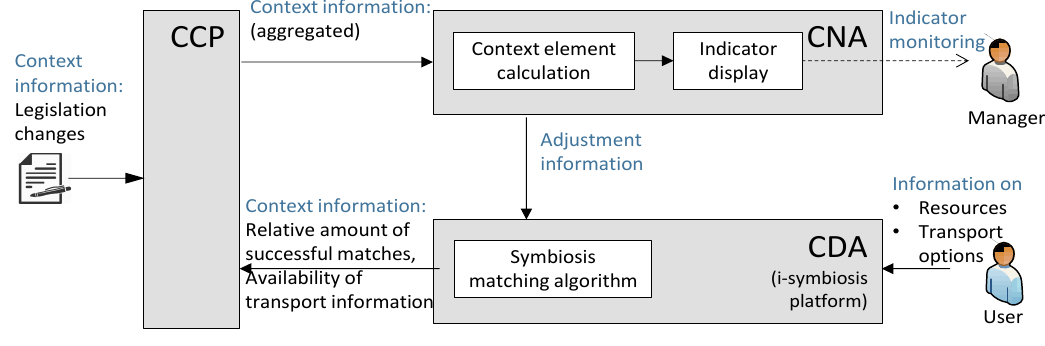
Figure 3. overview of the symbiosis case use of the CDD